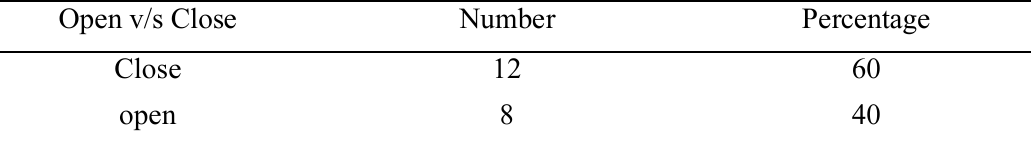
Table 3: Open V/s close fractures (n= 20)